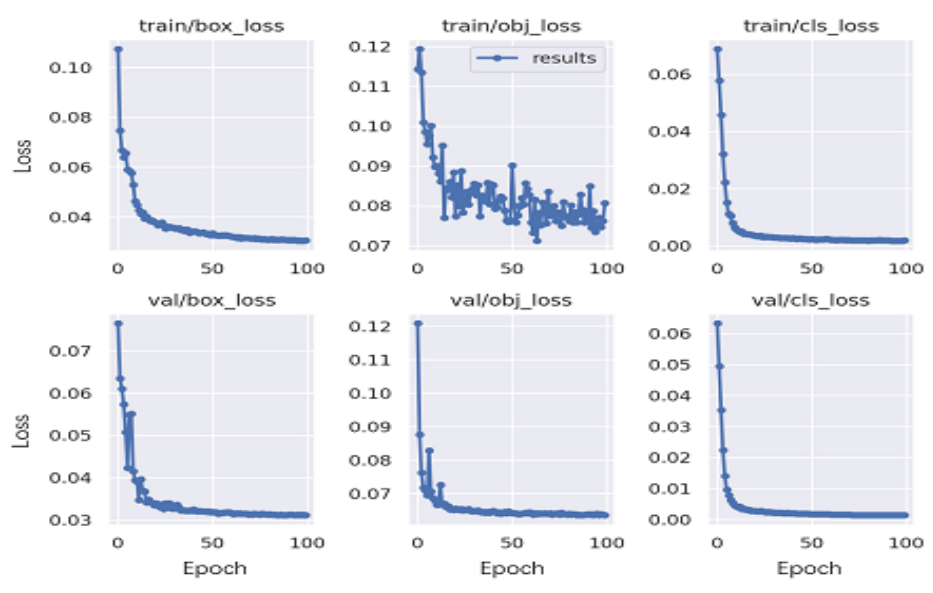
Figure 7. The loss of the model. The first line is the training loss, and the second line is the validation loss. The box_loss is the loss function of the prediction box; the obj_loss is the target detection; the cls_loss is the classification